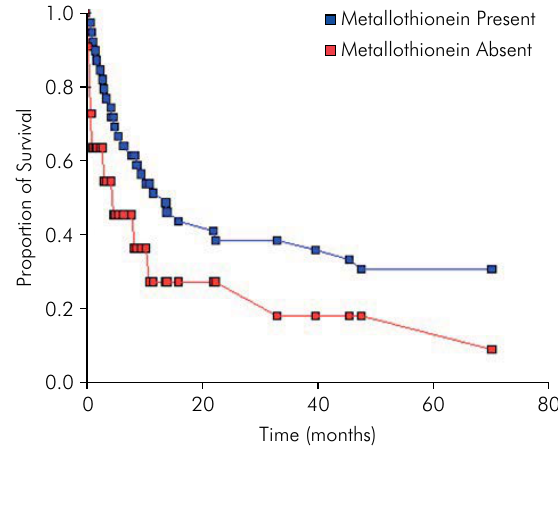
Figure 2. Survival rate association with metallothionein immunostaining (p = 0.0835).